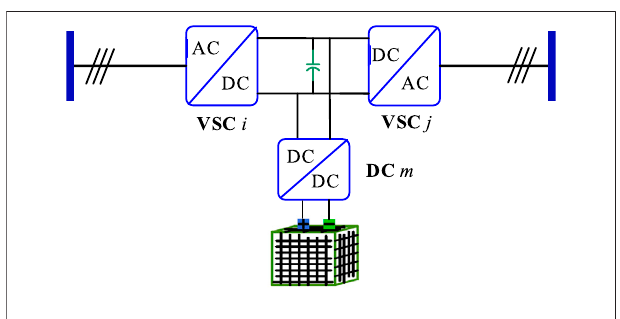
FIGURE 1 | The structure of SOP-based